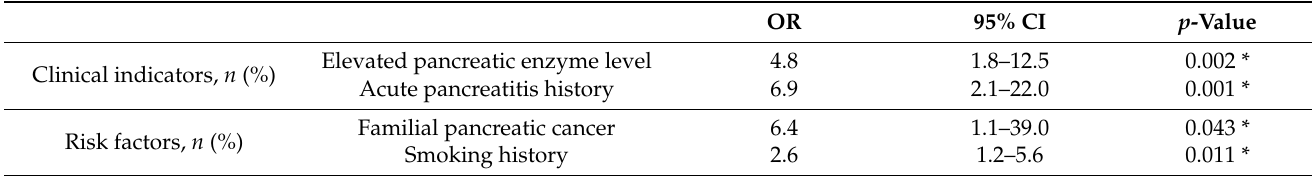
Table 3. Most significant factors in clinical indicators and risk factors: factors obtained from easy questionnaires and blood